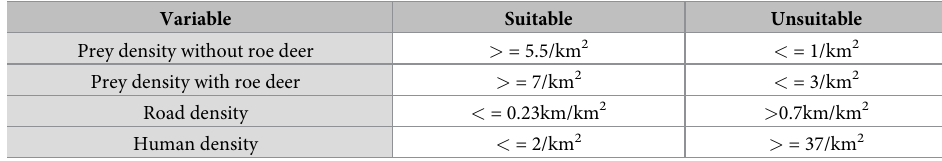
Table 3. Thresholds of